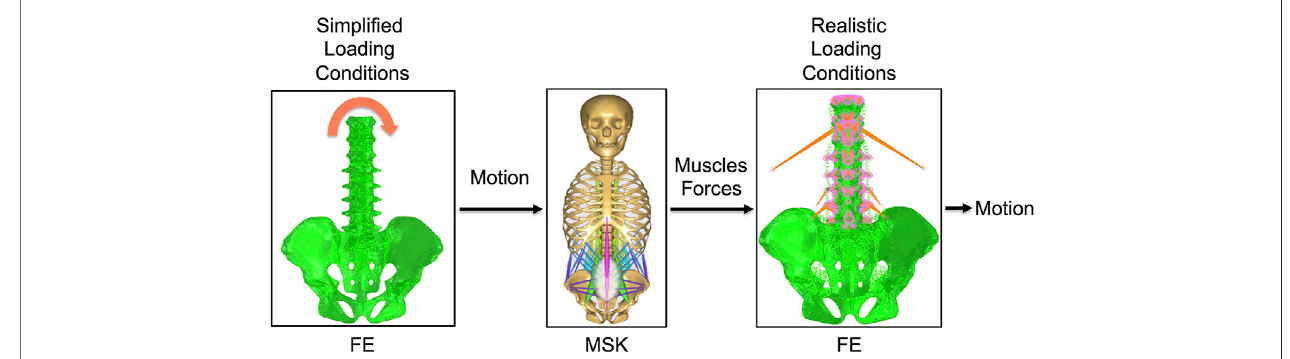
FIGURE 1 | The combination of the intact FE model with the intact MSK model. Simpli fi ed loading conditions are applied to the FE model in order to obtain the motion. This motion is imposed as input to the MSK model and muscles forces that contribute to give that motion are predicted by this model. Muscles forces are then applied to the FE model to realistically simulate the loading conditions. The motion under realistic loading conditions is then